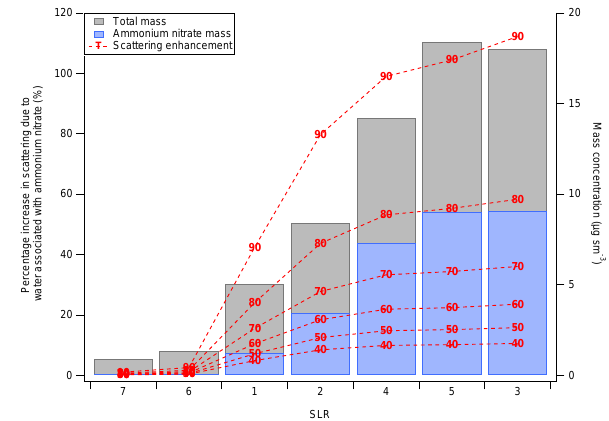
Fig. 10. Summary of the enhancement in aerosol scattering due to water uptake by ammonium nitrate aerosol derived from the Mie calculations. The text markers and hashed line refer to the percent- age increase in scattering by water associated with ammonium ni- trate over a relative humidity range from 40–90%. The Straight and Level Runs (SLRs) are from B379 and are ordered by increas- ing ammonium nitrate mass concentration or mass fraction. Also shown is the average total mass and ammonium nitrate concentra- tions for each of the